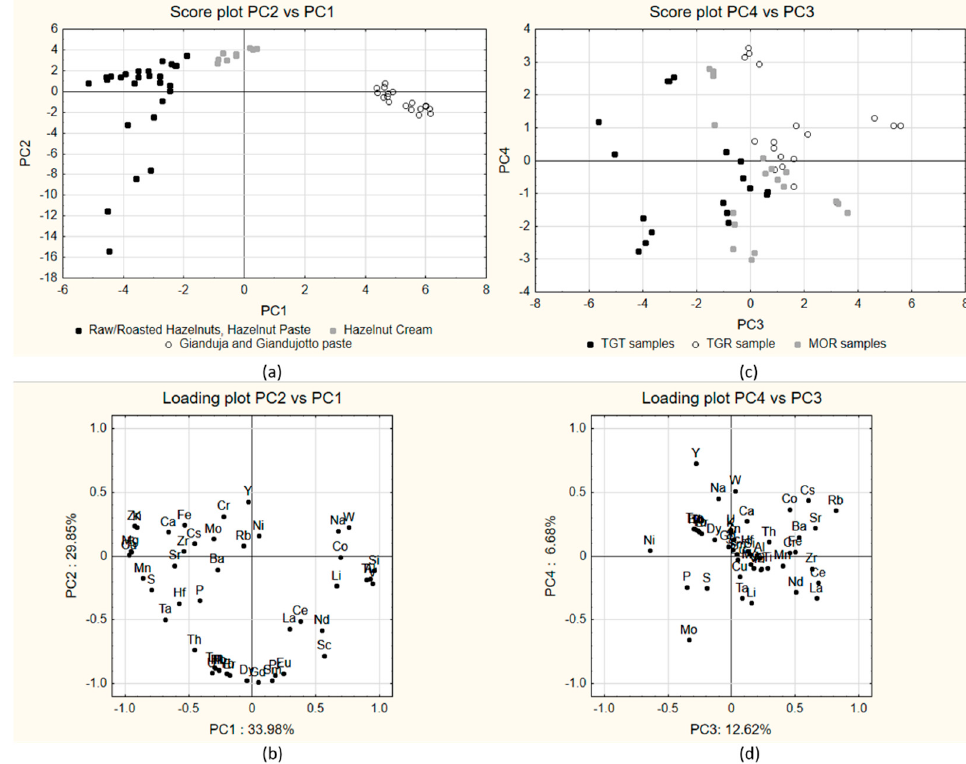
Figure 1. Results of PCA of the 54 samples, based on all variables: score plot ( a ) and loading plot ( b ) of PC1 vs. PC2; score plot ( c ) and loading plot ( d ) of PC3 vs. PC4.